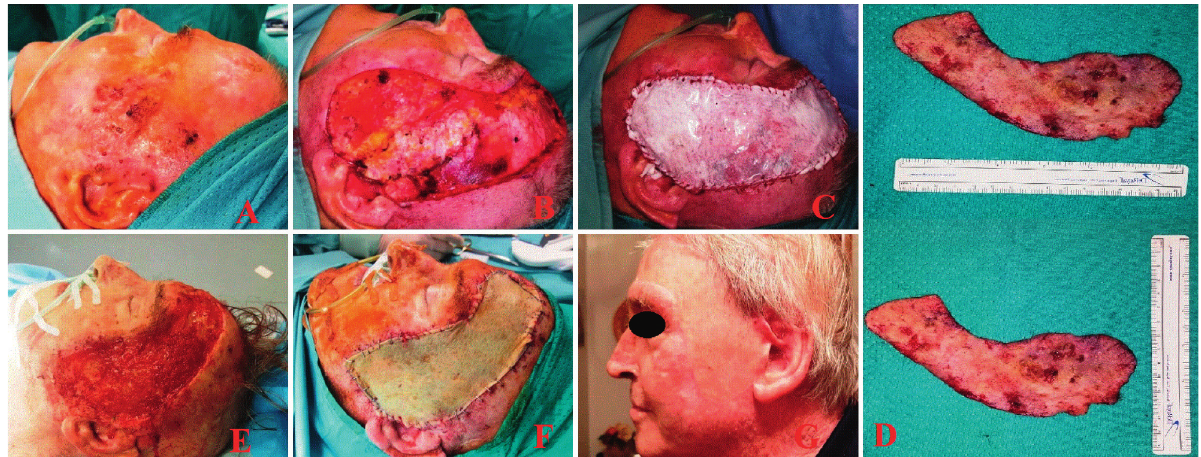
Figure 1: A clinical case of a 73yrs old man, with multiple recidivate BCC of face, underwent wide excision and reconstruction with Pelnac ® . (a) Preoperative view; (b) wide and deep excision of BBCs; (c) Pelnac ® on side; (d) surgical specimens; (e) wound bed after silicon layer peeled off; (f) split-thickness skin graft; (g) follow-up at 6 months.